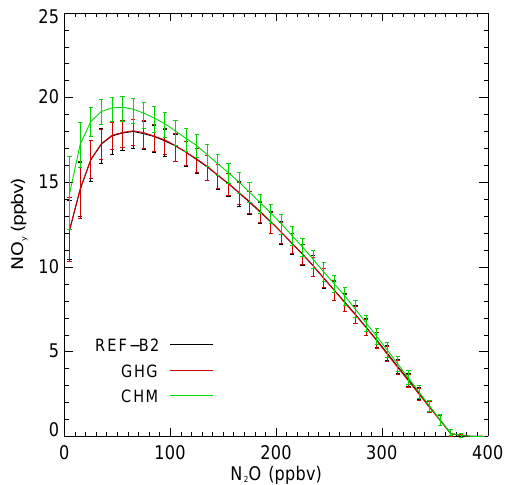
Fig. 7. The relationship between instantaneous concentrations of N 2 O and reactive nitrogen (NO y ) between approximately 150 and 1.0hPa and 15 ◦ S to 15 ◦ N for the years 2080 and 2083. Data is taken from one member from each of the three experiments, sampled three times a month, and has been binned according to N 2 O concentration. Each data point shows the mean concentration of NO y in each bin, with the vertical bars giving the 10th and 90th percentiles.